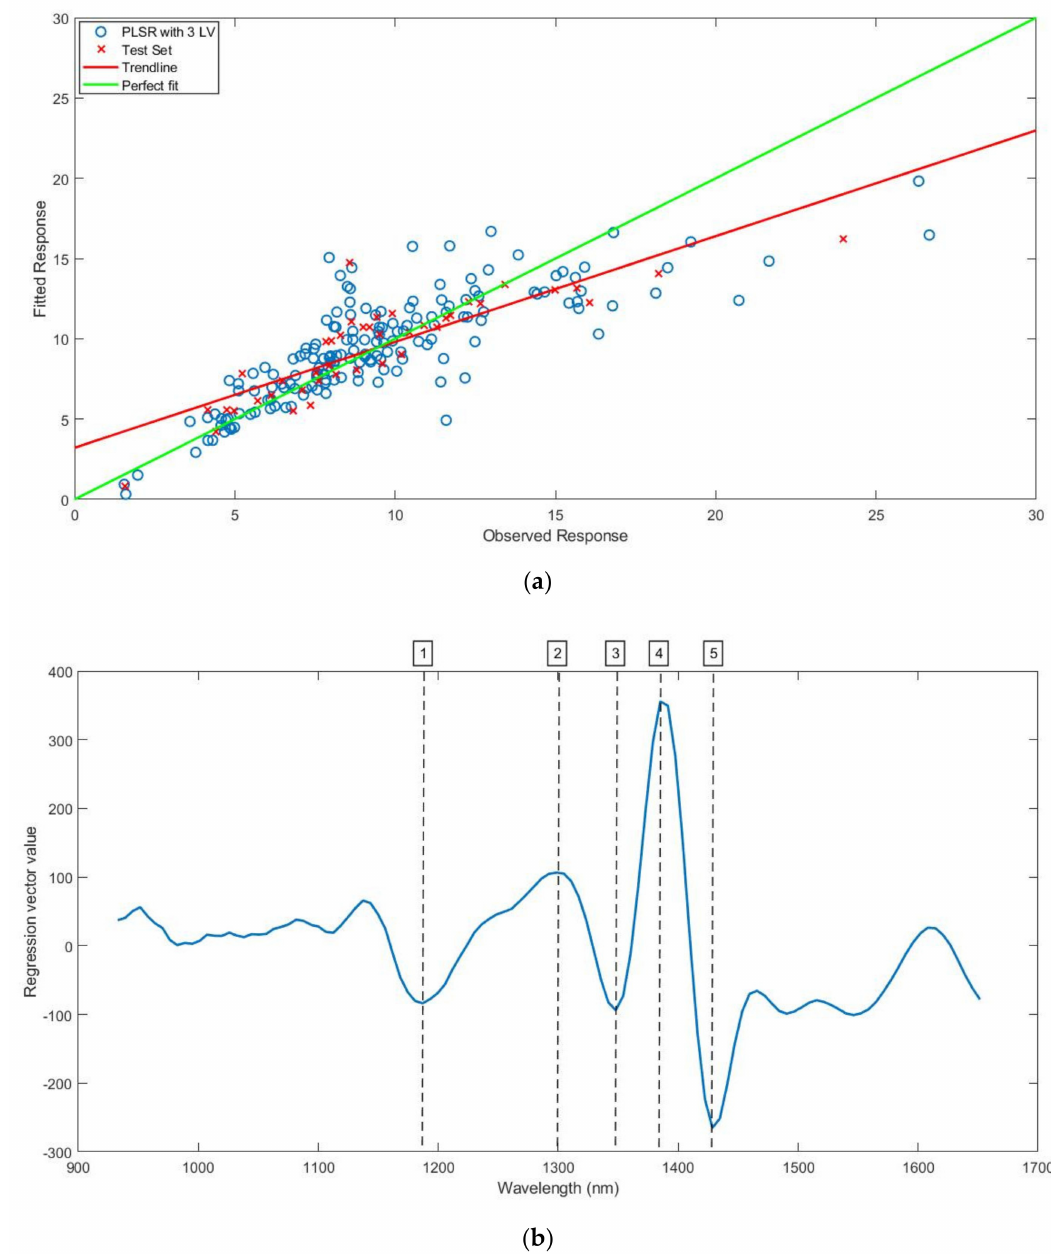
Figure 2. ( a ) Partial least squares regression plot for the prediction of BWC on WD st . Spectra were pre-processed by first order derivation using the Savitzky-Golay algorithm with nine smoothing points and three latent variables; ( b ) Corresponding regression vector plot using vertical lines and numbers to highlight the most important